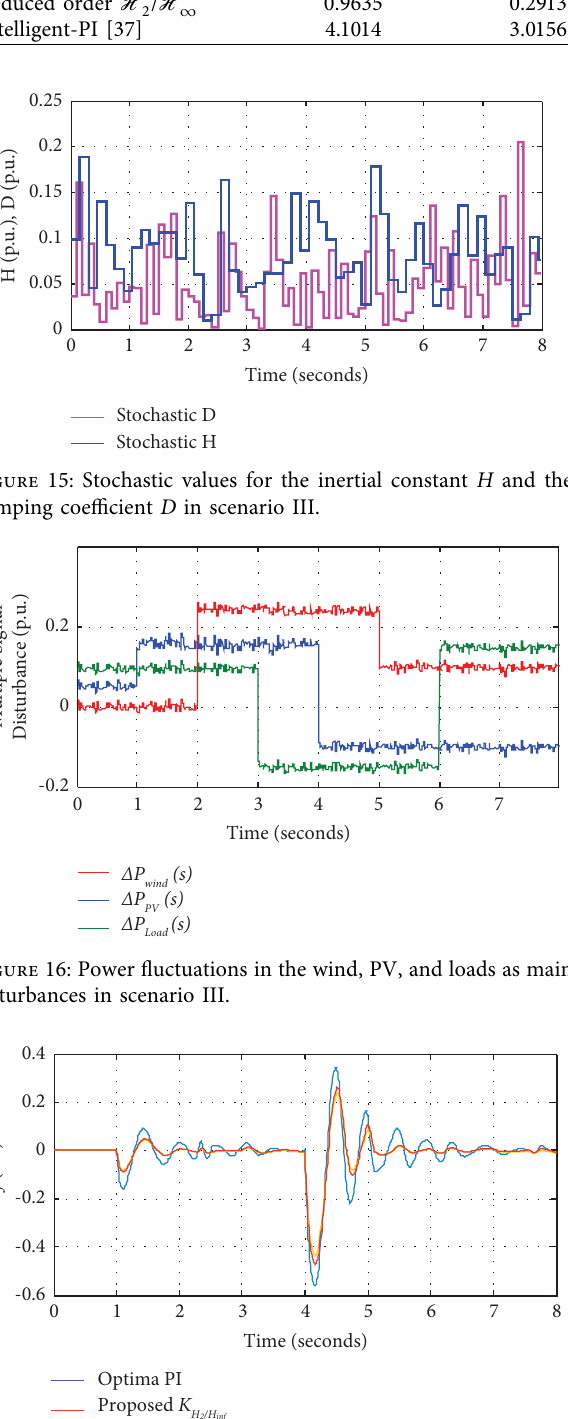
Figure 14: Comparison of the frequency response of the studied MG system equipped with the proposed robust VI, its reduced order form, and proposed intelligent self-tuning optimal PI pro- posed in [37], and linear quadratic regulator (LQR) presented in [11].